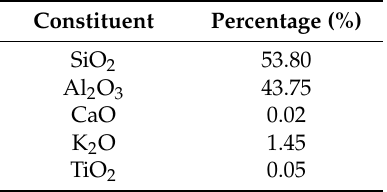
Figure 2. X Ray diffraction pattern of Speswhite kaolin. Table 3. Chemical composition of Speswhite Kaolin.